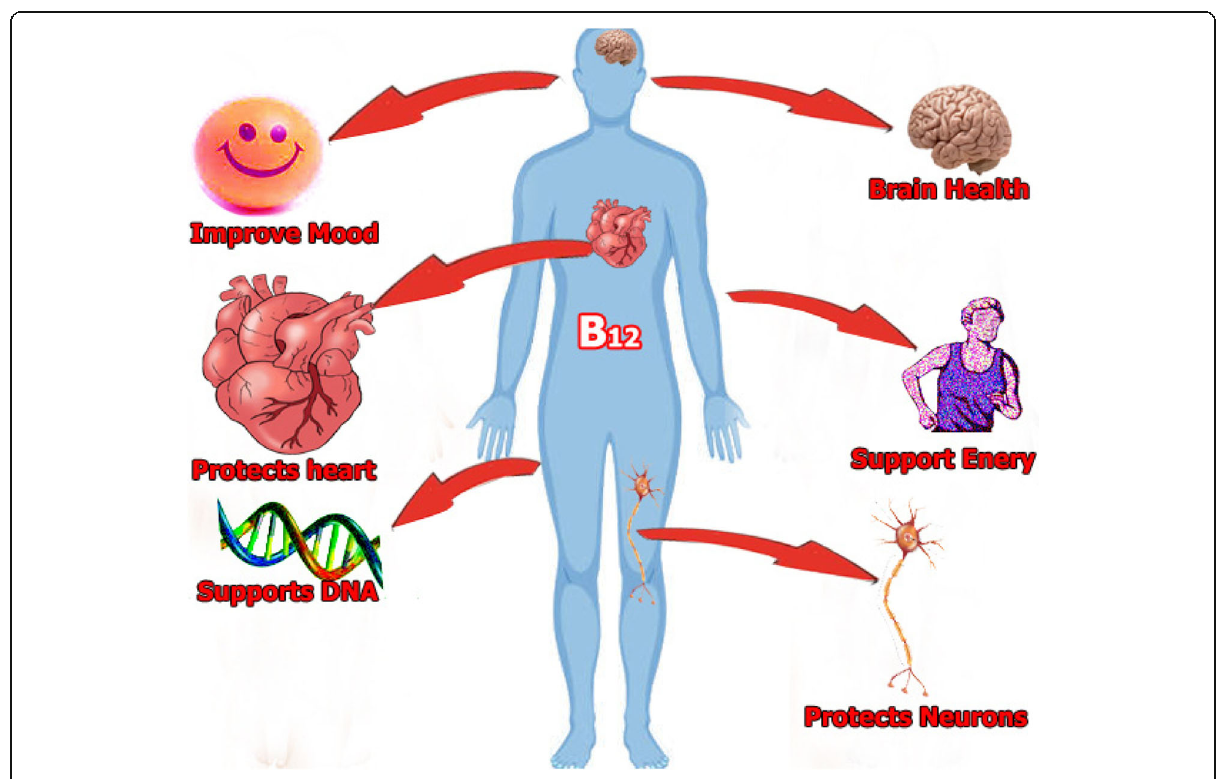
Fig. 3 Some key functions of vitamin B 12 in human